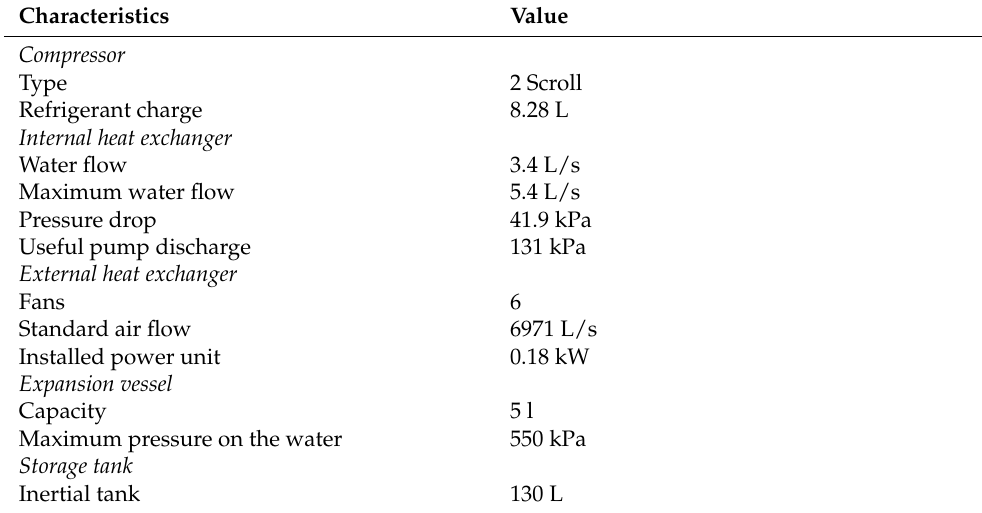
Table 1. Characteristics of the heat pump CLIVET WSAN-XEE 302